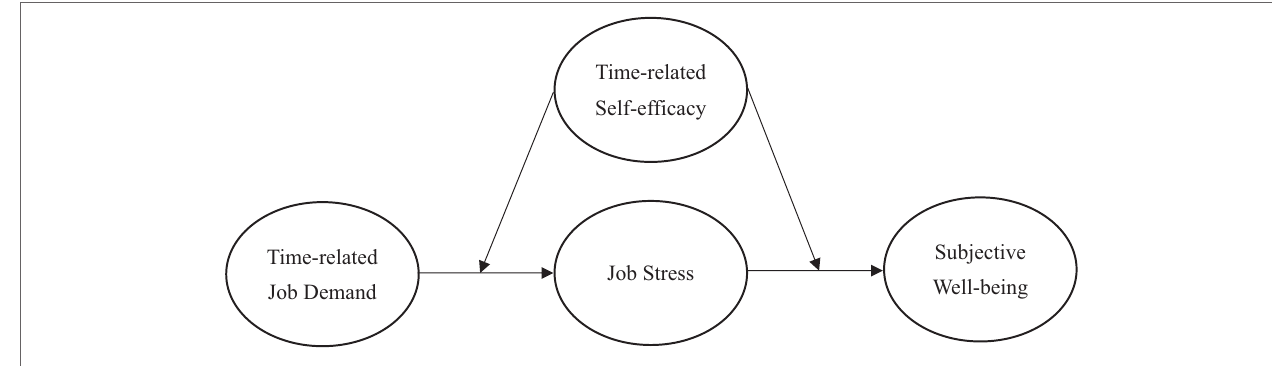
FIGURE 1 | Research